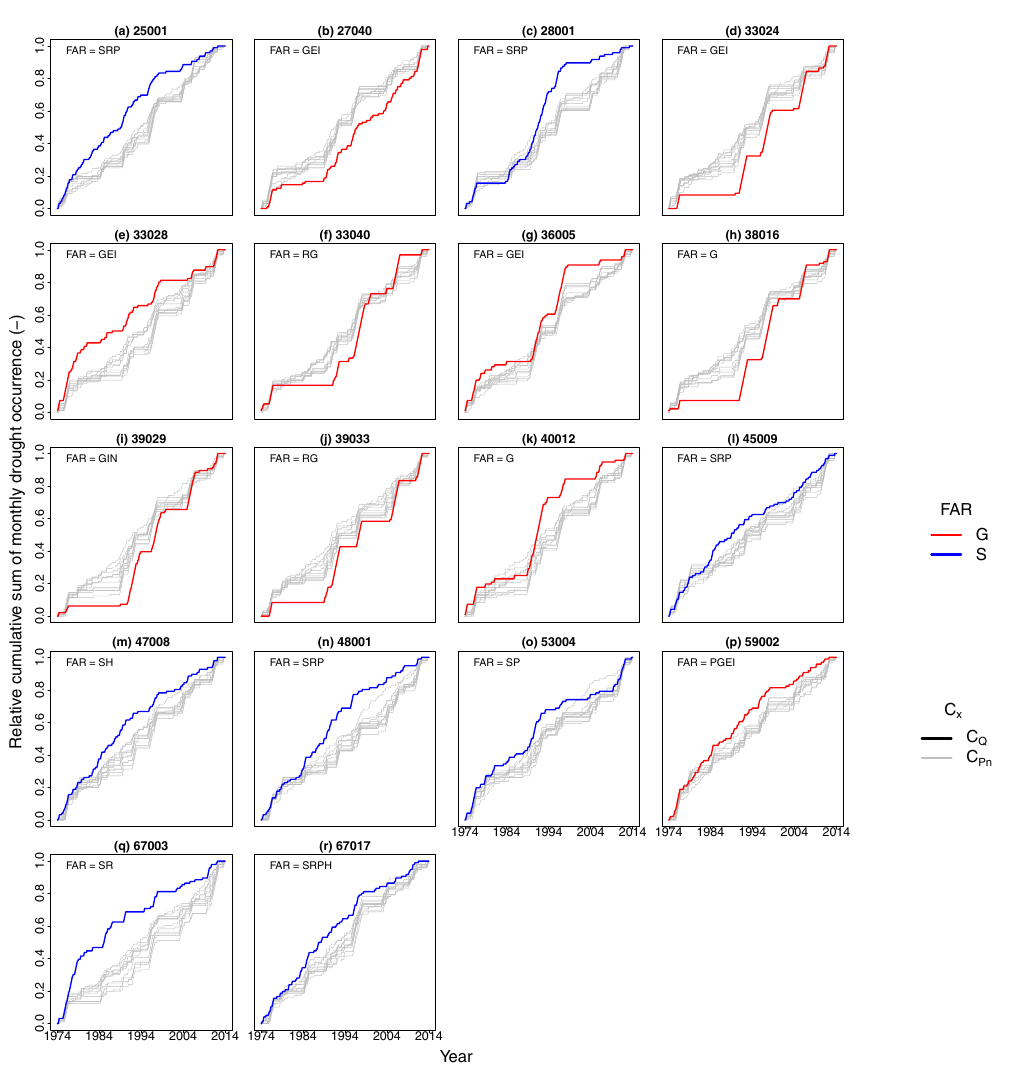
Figure 8. Relative cumulative sum of monthly drought occurrence ( C x ) for strongly influenced records of streamflow ( C Q , coloured lines; only FAR = G and FAR = S are shown) and precipitation ( C P station name of each